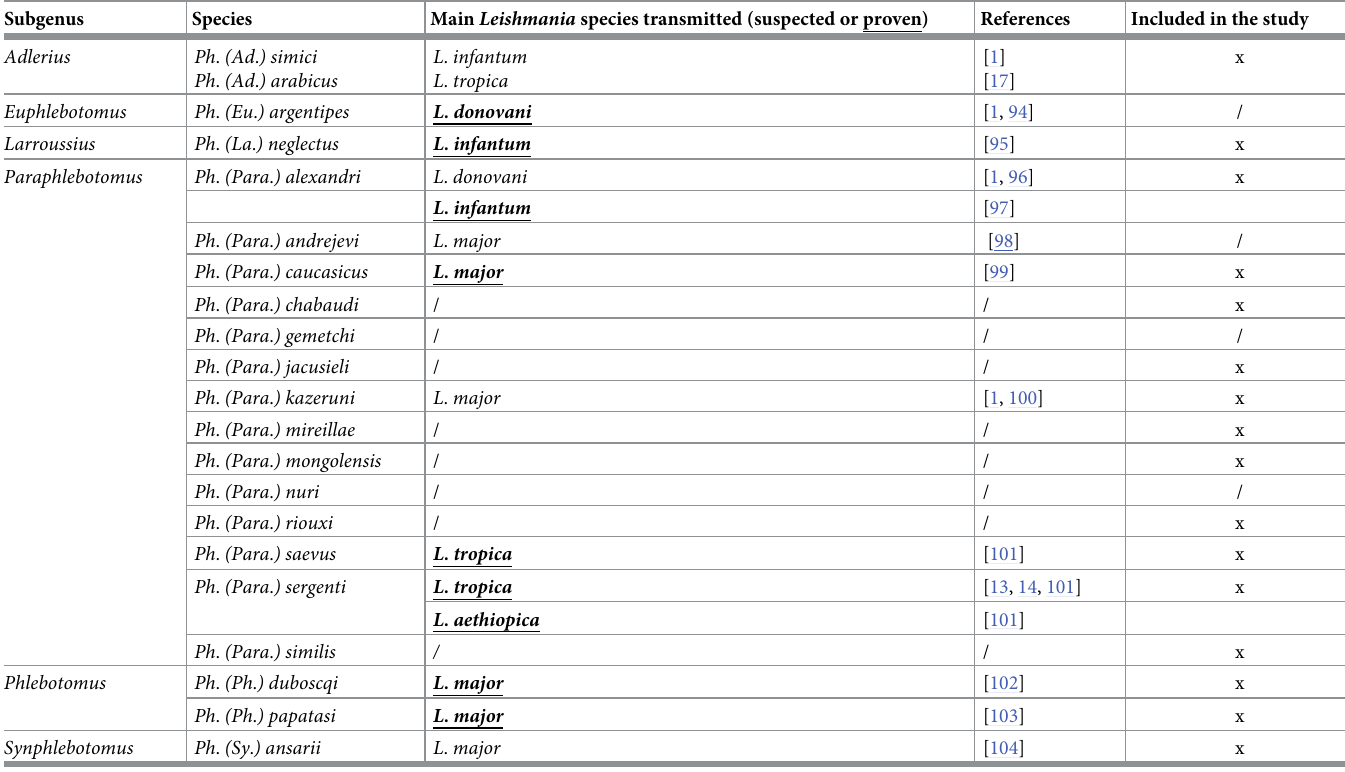
Table 1. Subgenera of Phlebotomus sand flies involved in Leishmania transmission. Subgenus Species Main Leishmania species transmitted (suspected or